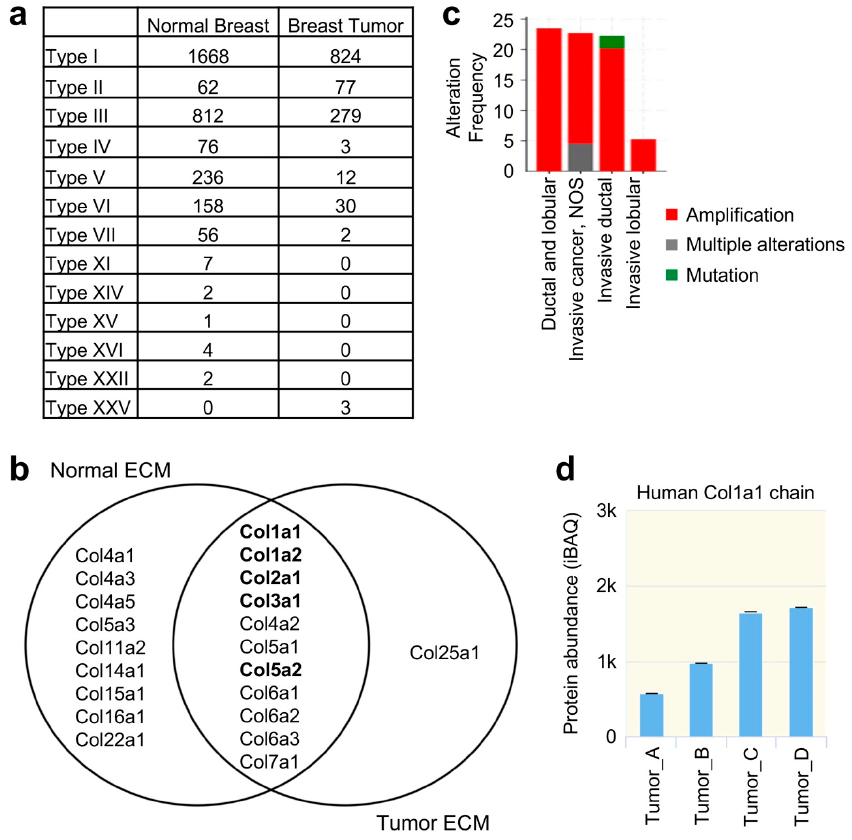
Figure 5. Collagen type and expression level differences between normal and breast tumor tissues. ( a ) A table showing the levels of the different types of collagens in mouse normal breast ECM and breast tumor ECM based on mass spectrometry analysis. ( b ) The common and distinct collagen chains identified in the normal breast ECM and breast tumor ECM. The collagen chains indicated in bold are the ones commonly found in MB-TMG, PB-TMG, and HB-TMG. ( c ) Col1a1 genetic alteration frequencies in invasive/metastatic human breast cancers. ( d ) Col1a1 protein expression increases in invasive human breast